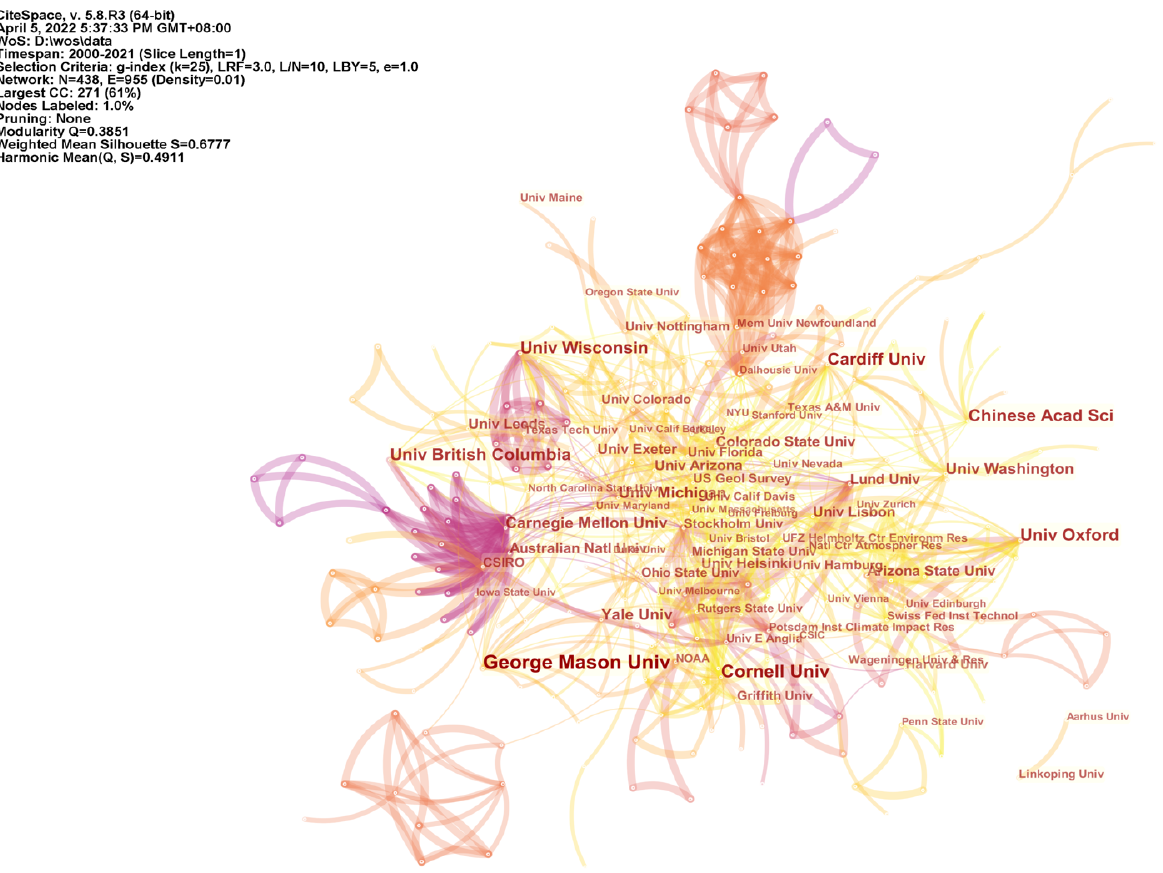
Figure 5. Institutional cooperation network.